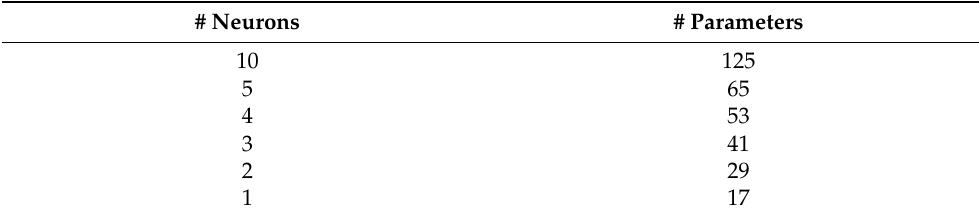
Table 3. Number of network parameters for six input signals and five output signals. # Neurons #